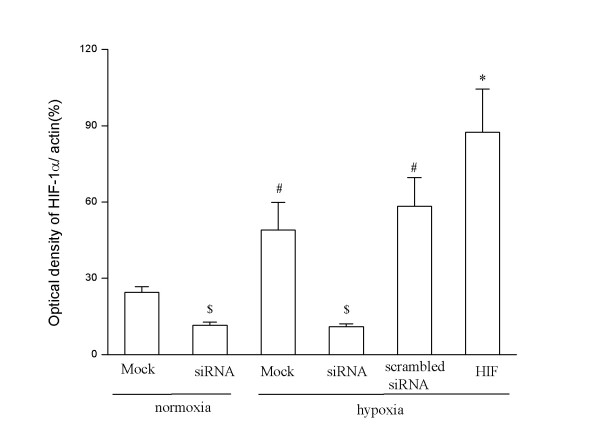
Suppression and over-expression of HIF-1α: graphical format. Densitometric analysis was performed on the western blot shown in figure 3 and displayed here in graphical format. $, P < 0.05 compared to control and HIF-1α siRNA; #, P < 0.05 compared to normoxic and hypoxic HIF-1α siRNA; *, P < 0.05 compared to hypoxic mock transfected and scrambled HIF-1α control siRNA transfection. siRNA: HIF-1α plasmid transfected, Mock: mock transfected, HIF: HIF-1α expression plasmid transfected.